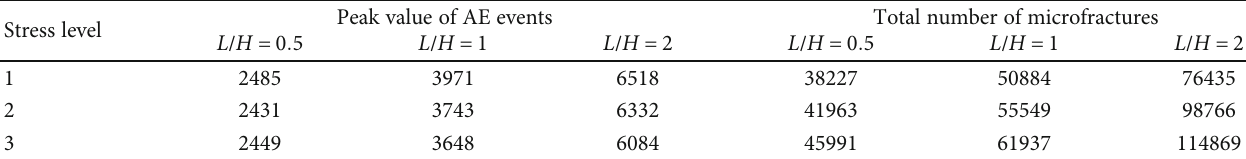
Table 5: AE simulation